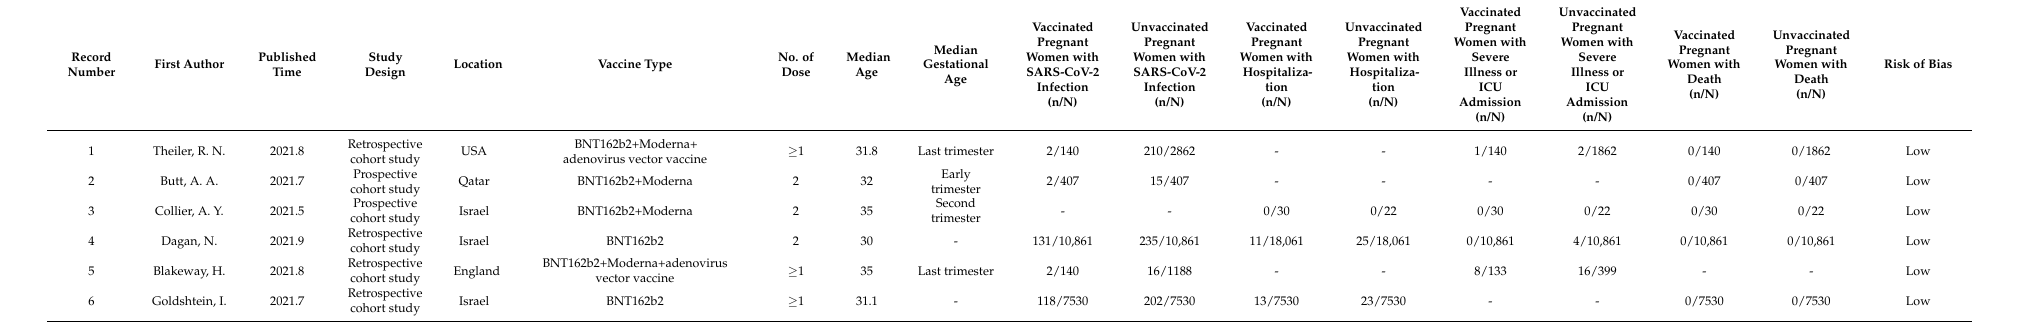
Table 1. Findings of included original studies for vaccine effectiveness.